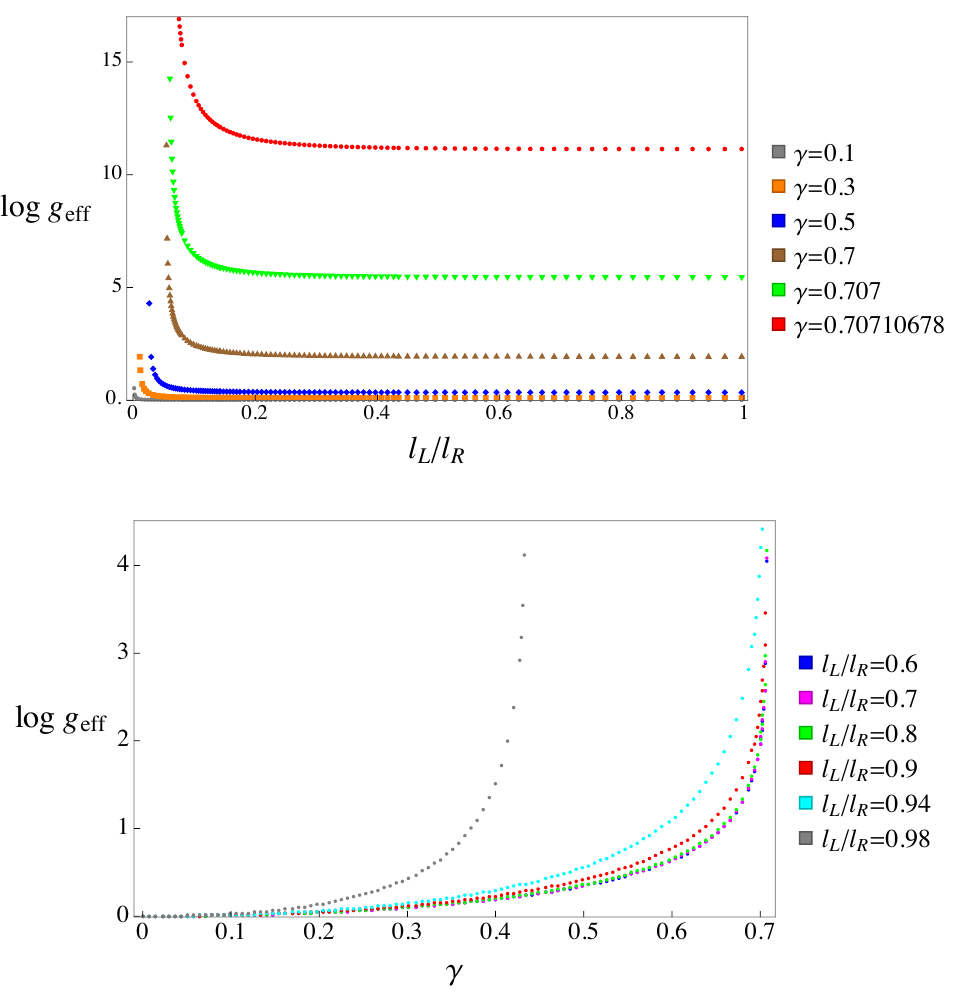
Figure 4 . Left: effective interface entropy as a function of the ratio l L /l R , computed from A ( γ ) − A (0) for various γ ’s [ A ( γ ) is the regulated area evaluated at γ ], similar to the procedure in [19]. As always, we have assumed l so the ratio takes value from 0 to 1 . The curves blow L ≤ l R up on the left side near the limit of the maximally asymmetric interval, signaling a change of the l -dependent behavior as described in sections 1 and 2, and also summarized in figure 2. The satu- ration of the interface entropy on the right side of the curves is consistent with know results [19]; up to four significant figures, those values are 0 . 0101 , 0 . 09922 , 0 . 3466 , 1 . 956 , 5 . 439 , and 11 . 14 , from √ bottom up. Right: interface entropy as a function of γ for various l . Near γ = 1 / 2 , all curves L /l R blow up but never intersect each